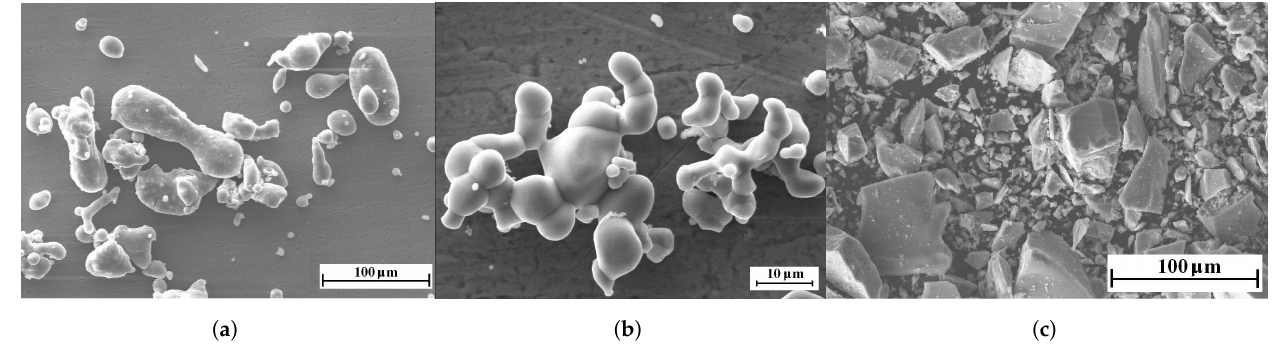
Figure 1. SEM images of the powders used for the cathode compactions: ( a ) Al; ( b ) Cr; ( c ) Si. The cathodes of Al 0.7 Cr 0.3 , Al 0.65 Cr 0.25 Si 0.1 , and Al 0.6 Cr 0.2 Si 0.2 (at.%) compositions were investigated. The coatings were deposited in N 2 gas under 0.065 Pa pressure and a 90 A arc current for 60